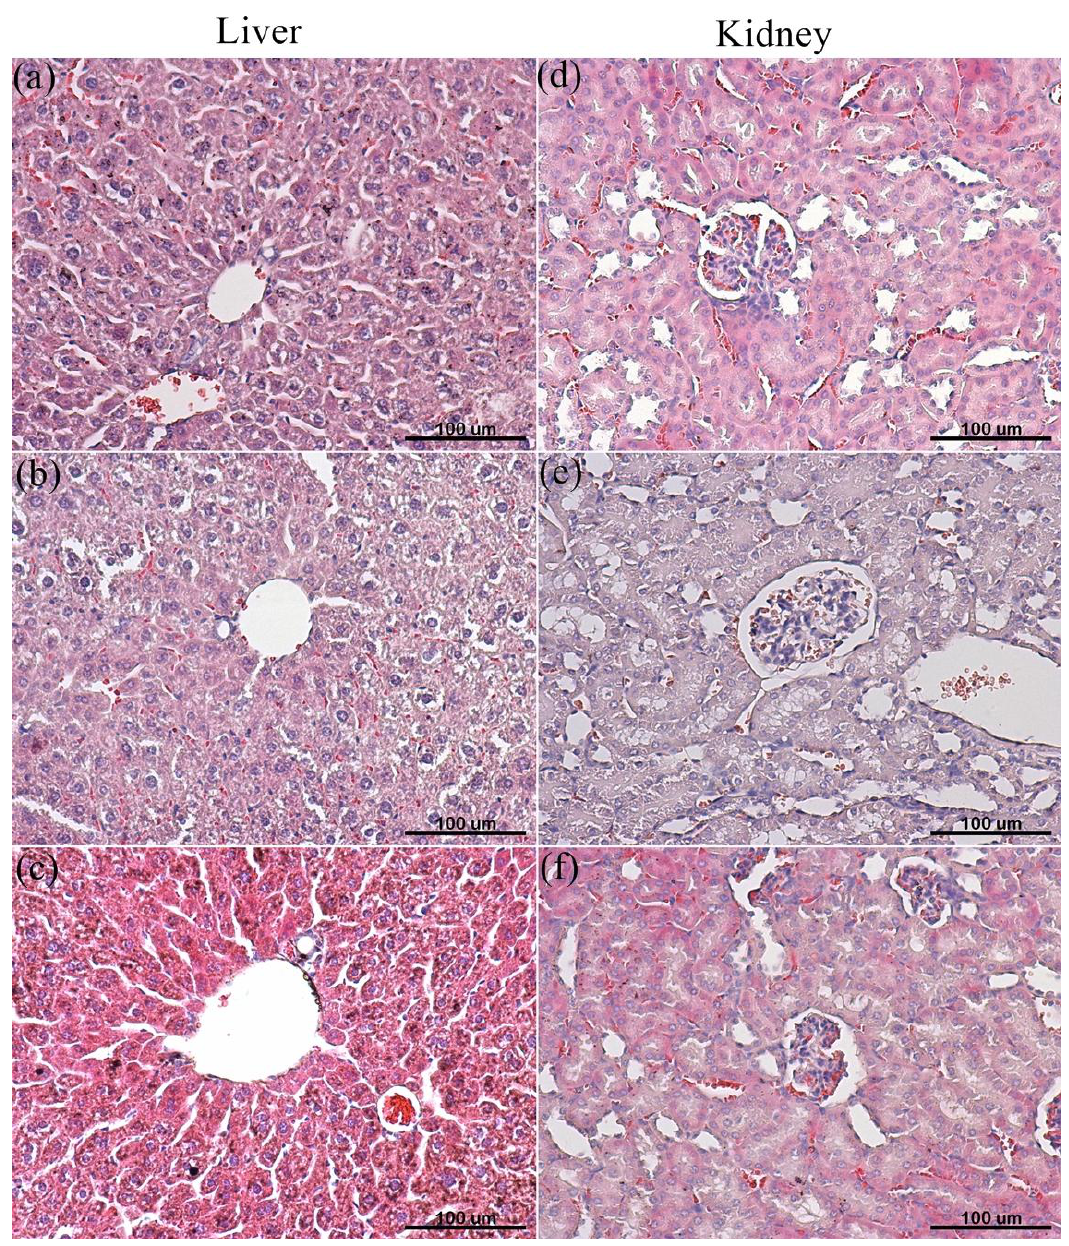
Figure 7. In vivo acute toxicity of PEG-PCL-PEG micelle treated mice. Each organ was evaluated by H&E staining after 14 days post-injection. ( a ), ( d ) Control; ( b ), ( e ) Single dose; ( c ), ( f ) multiple doses (scale bar: 100